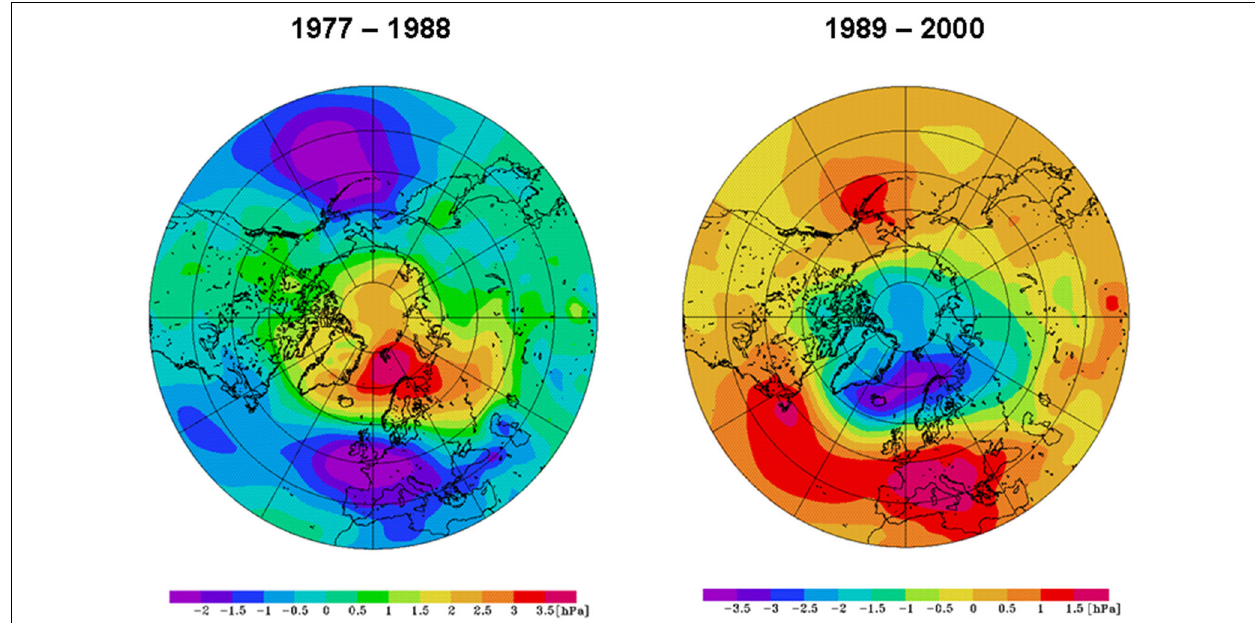
FIGURE 2 | Winter (Dec–Mar) sea-level pressure for the periods 1977–1988 (left) and 1989–2000 (right).